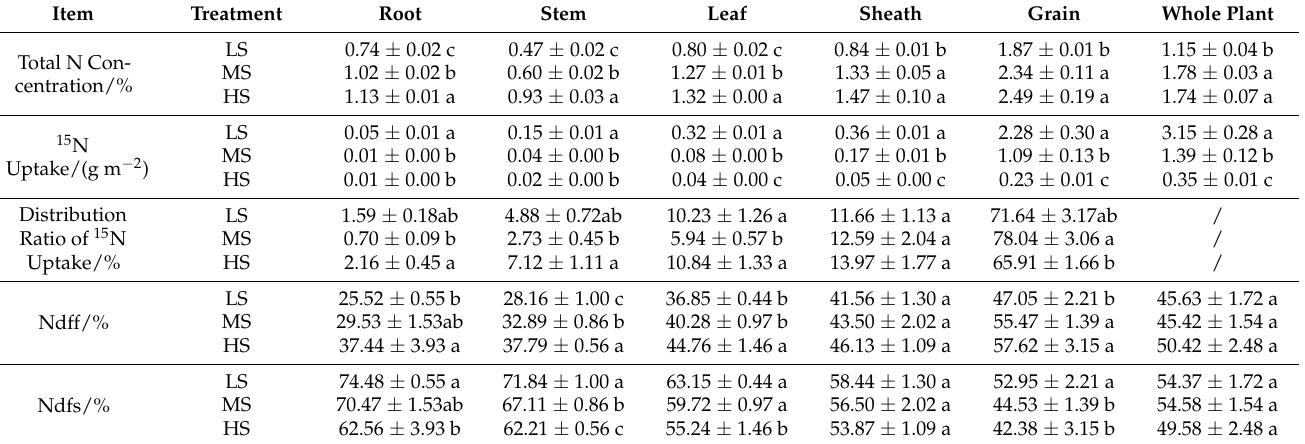
Table 3. Total N concentration, 15 N uptake, distribution ratio of 15 N uptake, Ndff, and Ndfs in wheat parts of different